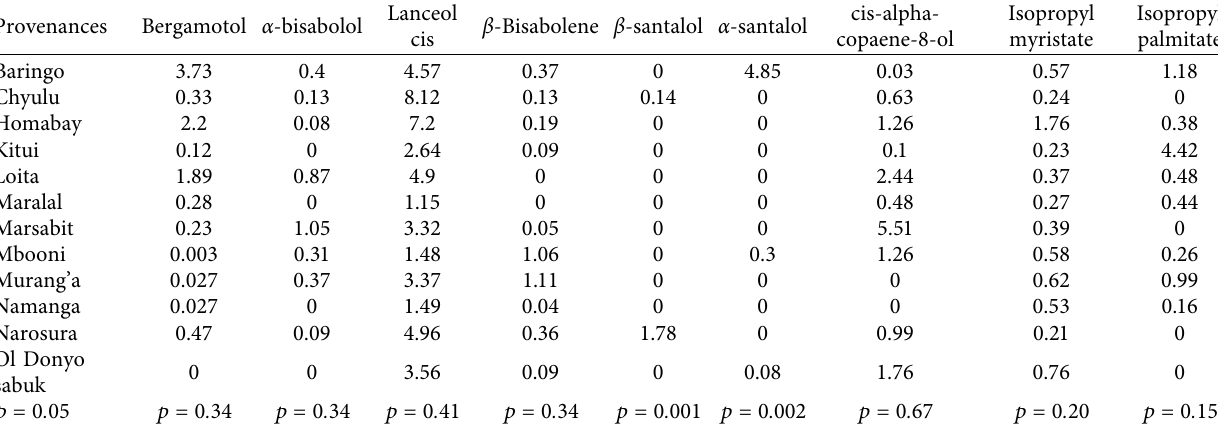
Table 6: Mean% concentration of most abundant compounds across diferent provenances in Kenya.